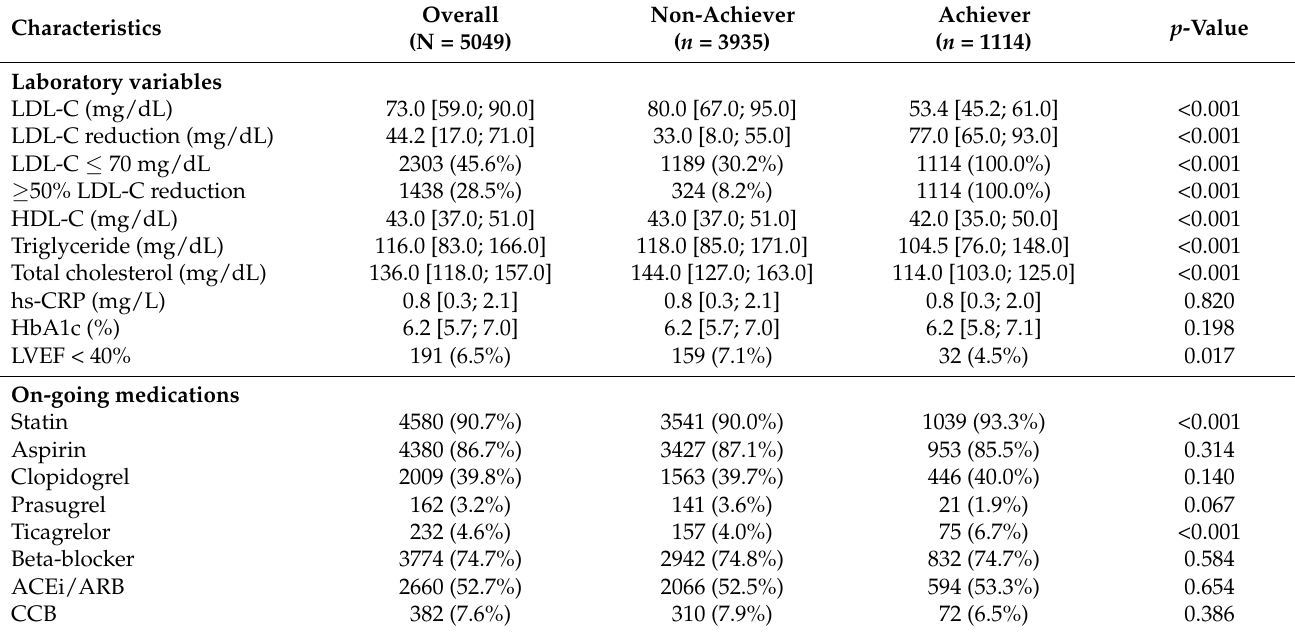
Table 2. Laboratory findings and medications at one-year